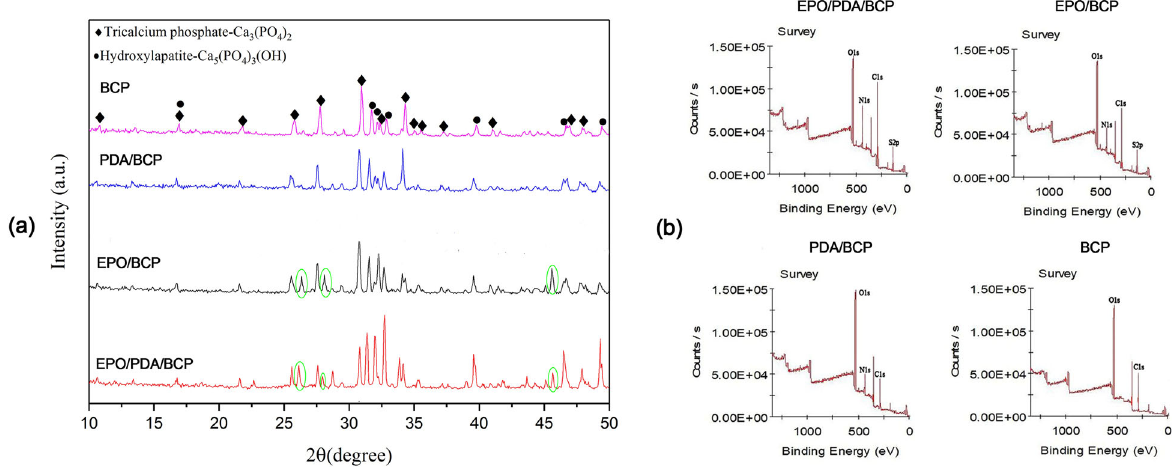
Fig. 2 a XRD patterns of the surface-modi fi ed and unmodi fi ed BCP bioceramics. The circle indicates the additional diffraction peaks in three regions besides the characteristic peaks of BCP. b XPS spectra of the surface-modi fi ed and unmodi fi ed BCP